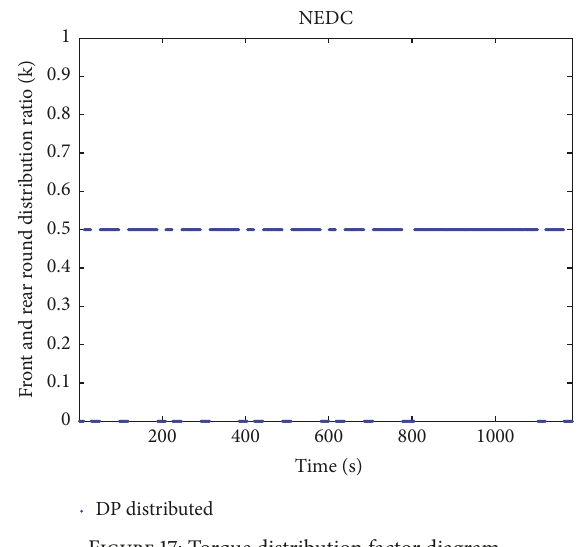
for dynamic programming control strategy, and the energy consumption is 20.25 kWh of electric drive system per 100